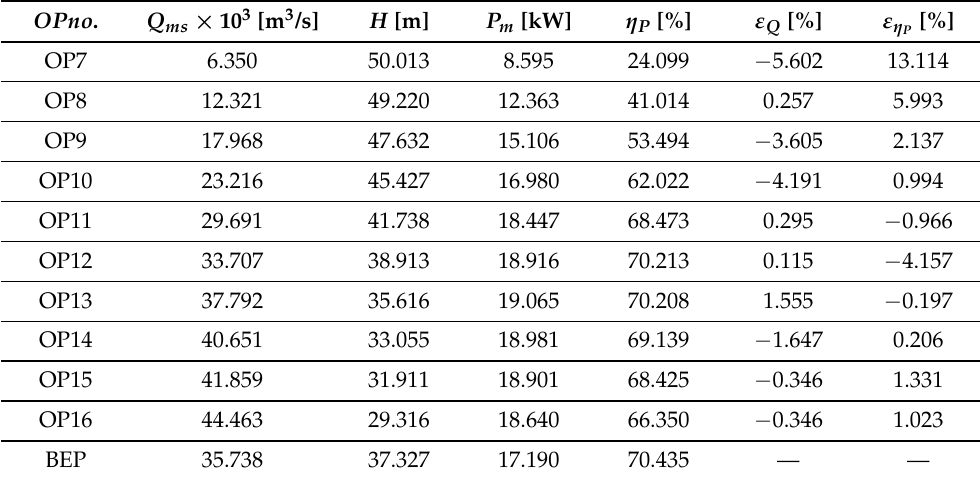
Table 5. The data computed by the software module for centrifugal pump PCN 65/200 at speed of 2900